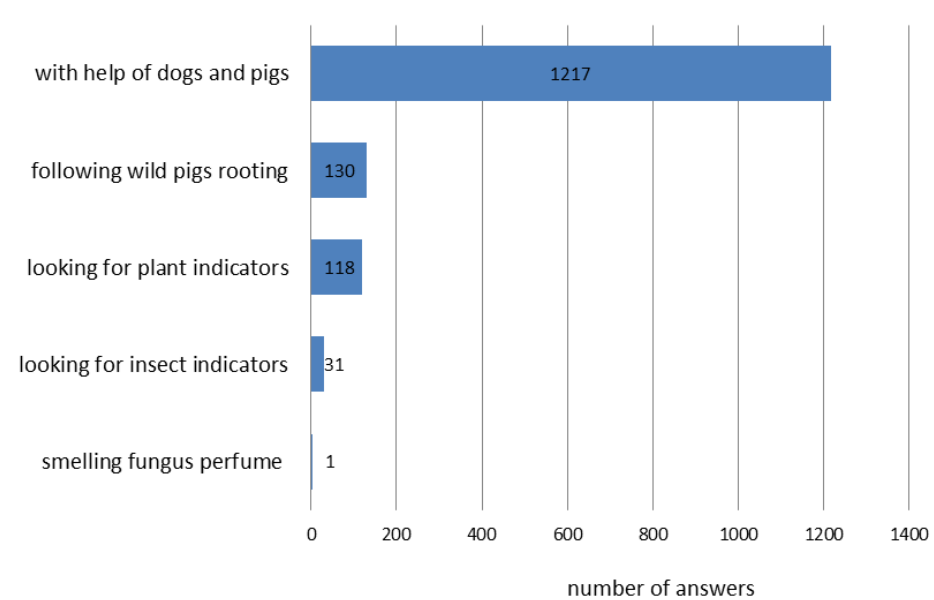
Figure 2. Methods of truffles collection known to respondents.